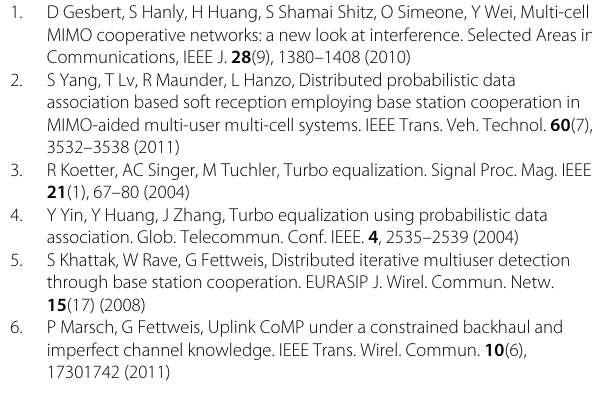
improvement is due to the appropriate manipulation of the a priori probability. The future direction will be com- plexity reduction for the distributed PDA